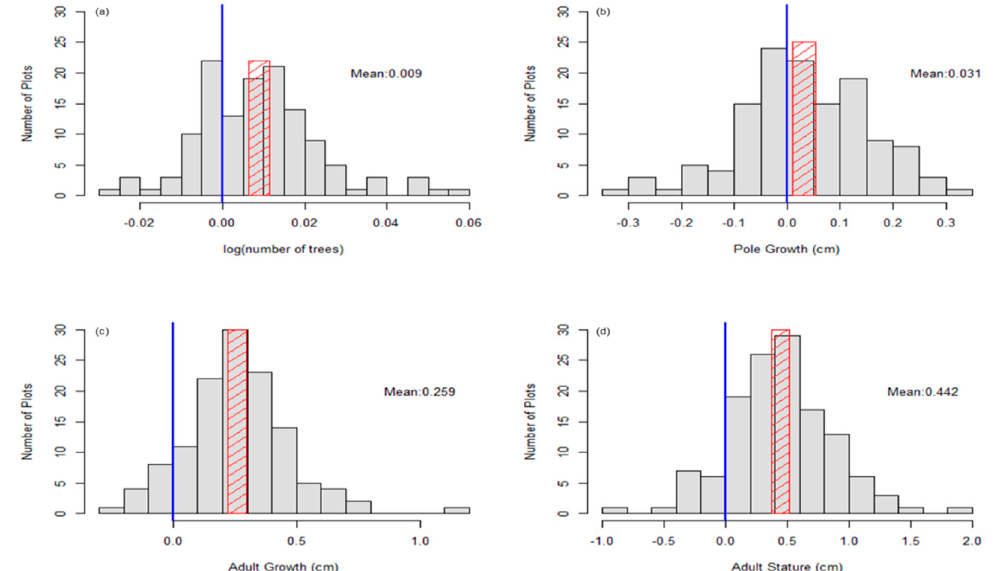
Figure 4. Histograms of the annual rates of change for each 0.1 ha subplot tree community across Mts. Jiri and Baegun: ( a ) stand prevalence represented as log(number of trees), ( b ) pole growth rate represented as log(dbh t+1 − dbh t )/time, ( c ) adult growth rate represented as log(dbh t+1 − dbh t )/time, and ( d ) adult stature represented as the 95% quantile of species’ diameter measurements (cm). The blue line indicates the null hypothesis of zero net change and red hatched areas indicate 95% confidence intervals around the mean rate of change for each variable.